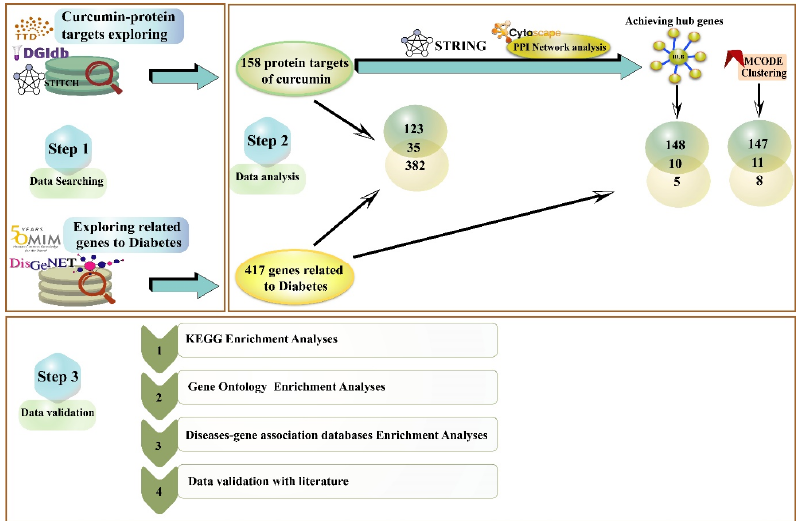
Figure 1. An overview of an investigative process undertaken in the present study. This investigation is organized into three sections: (Step 1) exploring the gene/protein target of curcumin and diabetes in different databases. (Step 2) Analyzing two data sets of curcu- min targets and diabetes-related genes/proteins and discovering the associations. (Step 3) Probing the pathways and biological process, and gene-disease enrichment analysis re- lated to obtained important intersection protein/genes, and then validation with a litera- ture